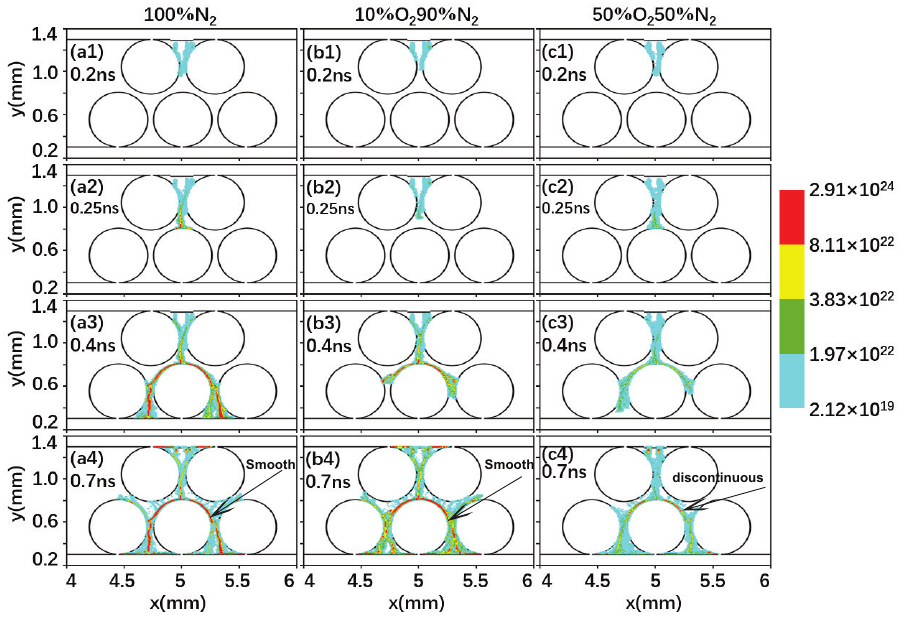
Figure 9. N + ion density (m − 3 ) for the same conditions as in Figure 2